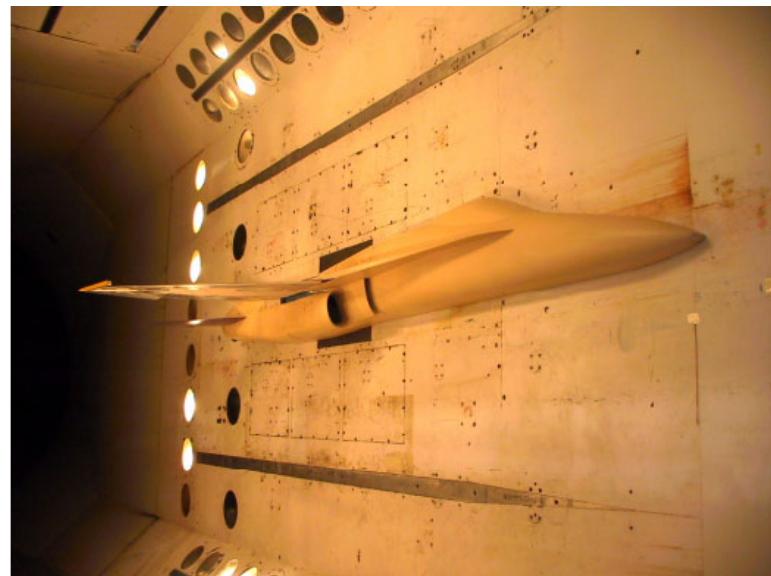
Figure 9. Photographs of model tests, Adapt with permission from [61].